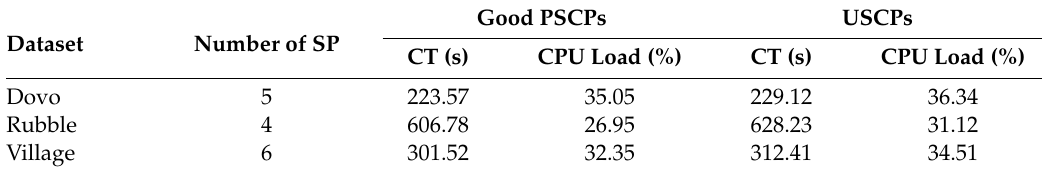
Table 3. Performance analysis for the semi-automated registered global UAV-UGV maps.